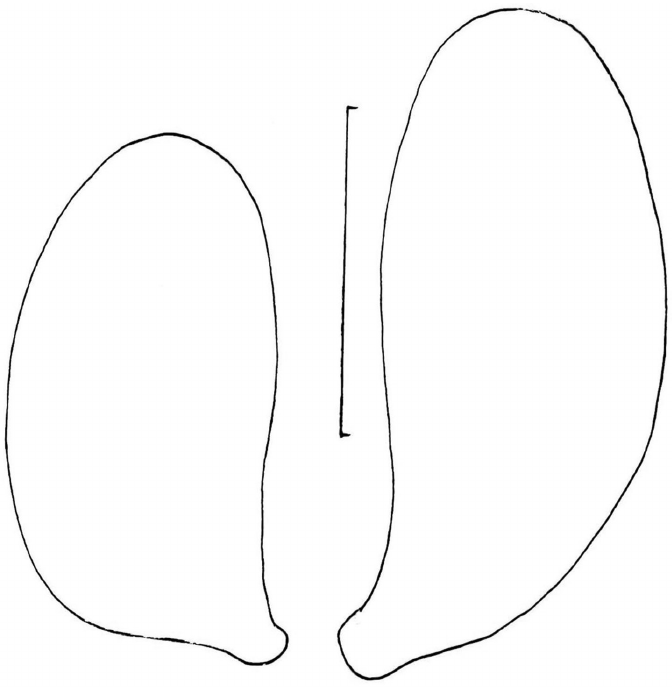
Figure 75. Mycetinis scorodonius . Basidiospores. Standard bar = 5 µm. TFB 7261 (TENN-F-